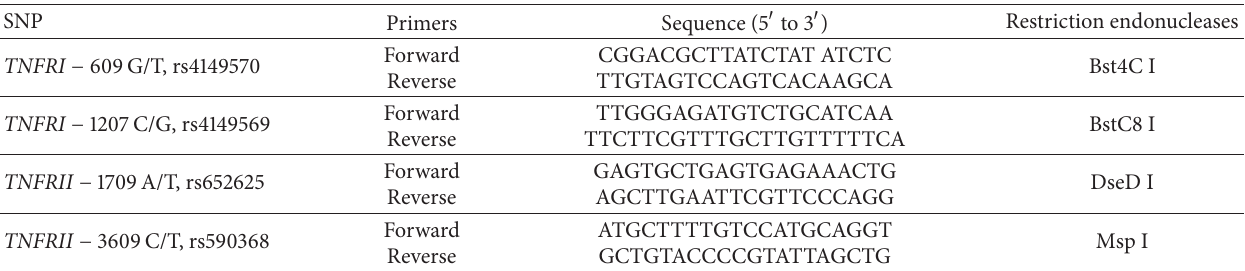
Table 1: Primers and restriction endonucleases used for SNP genotyping.